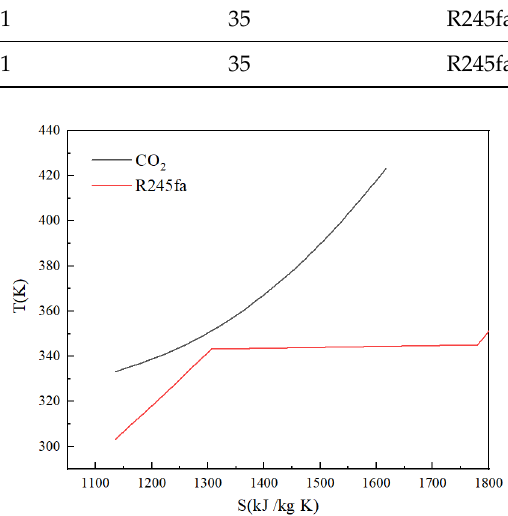
Figure 4. Temperature distribution inside heat exchanger 1.